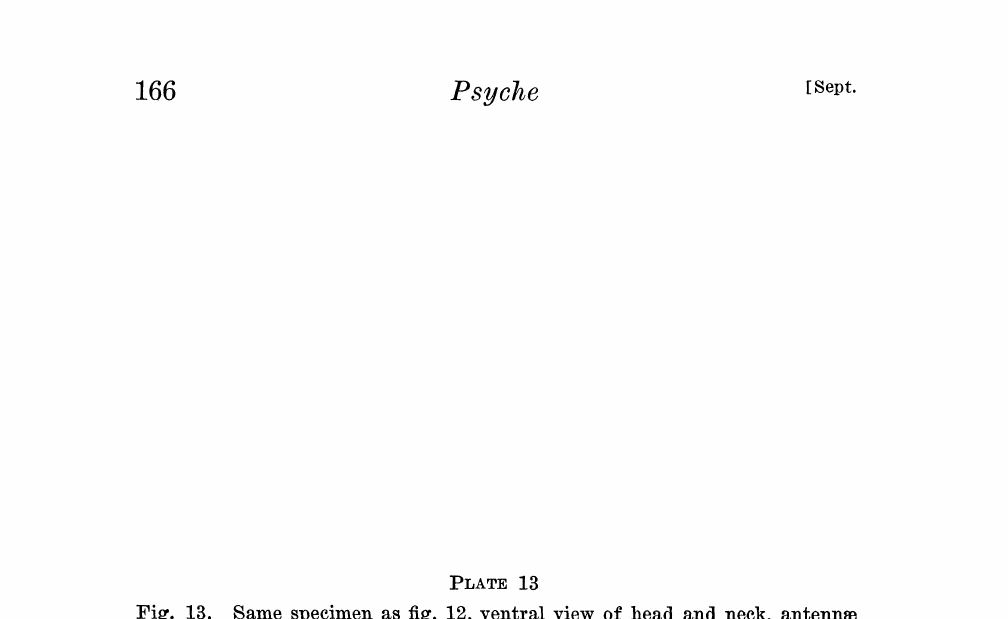
PA 13 Same specimen as fig. 12, ventral view of head and neck, antennm Fig. 13. omitted. Nallachius americanus, mature larva, ventral view of head and Fig. 14. neck, antennm omitted. Same specimen as fig. 6. Same, adult female, right lateral view of apex of abdomen, only Fig. 15. base of ovipositor shown. Brookline, Pittsburgh, Pa. Same, pupa, left lateral view. Length, 3.26 Fig. 16.